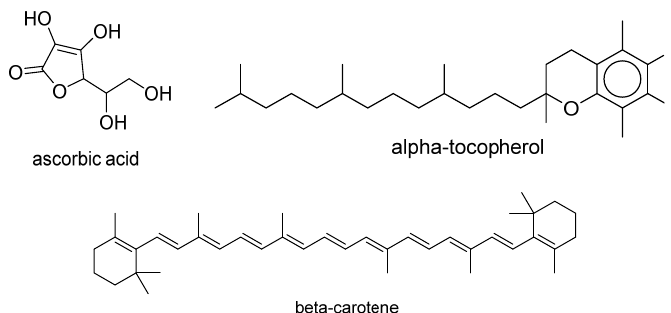
Figure 1. Examples of compounds in dataset.